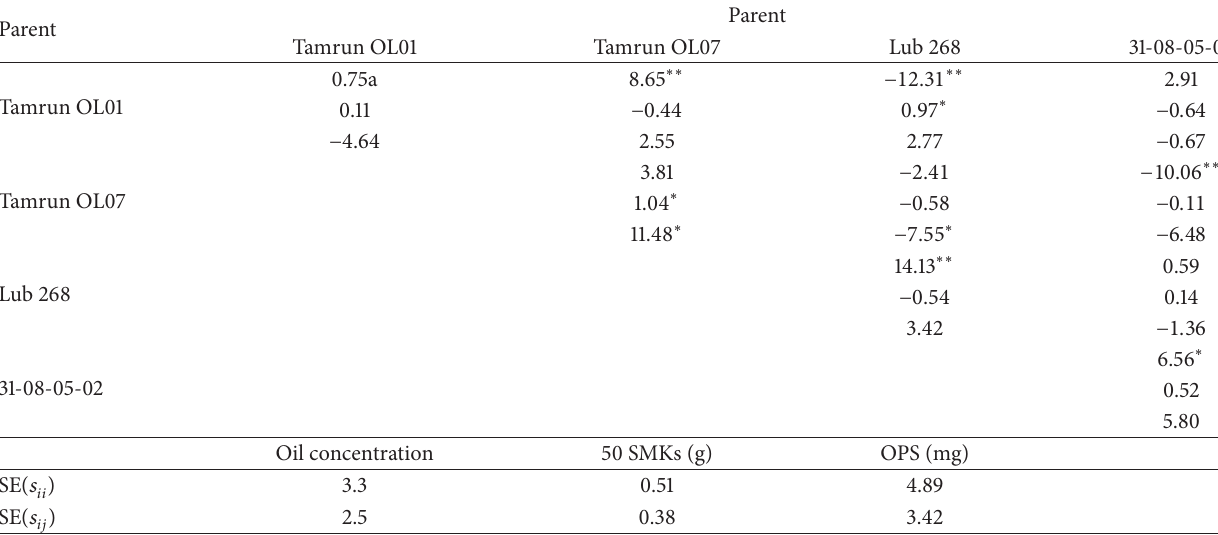
Table 4: Estimates of SCA effects and standard errors for oil concentration in gkg − 1 , weight of 50 sound mature kernels (50 SMK) in